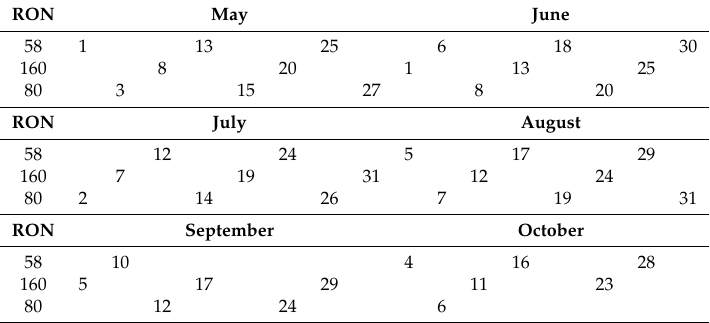
Table 2. Acquisition dates for different